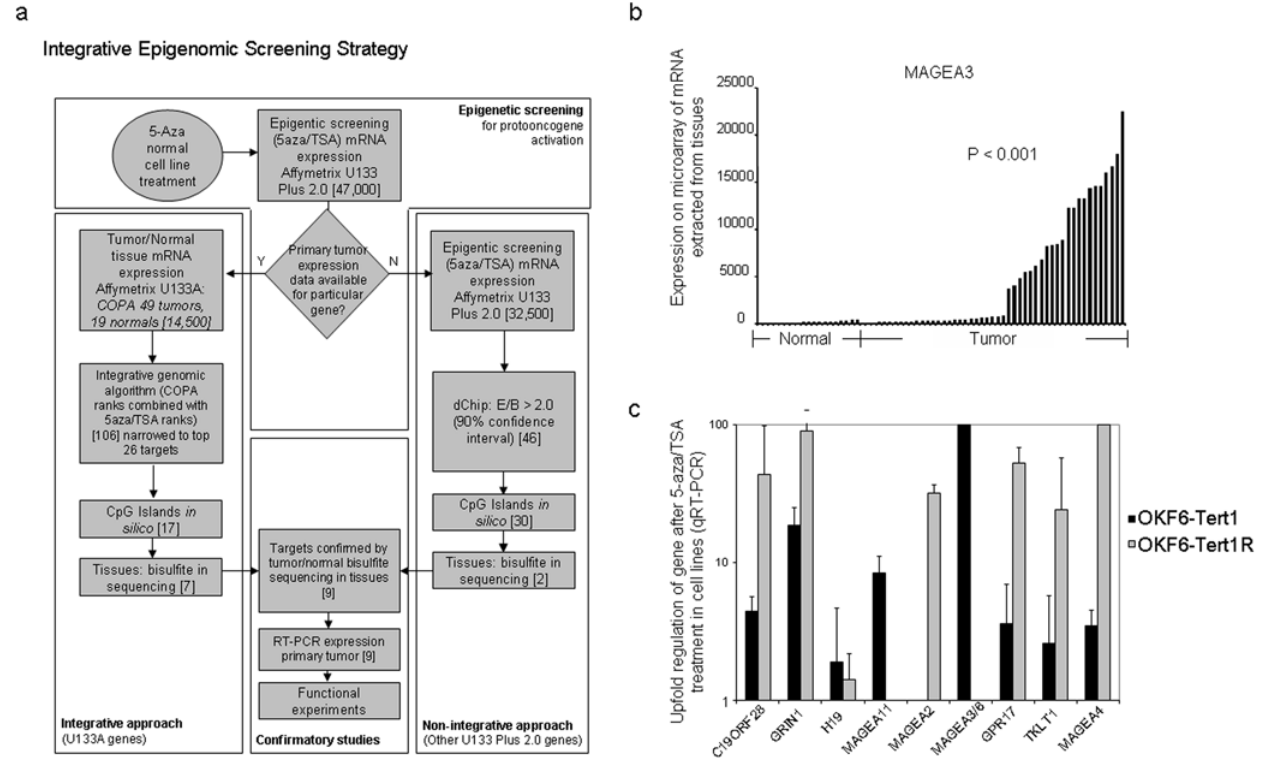
Figure 1. Integrative epigenetic screening strategy and strategy for validation of targets. ( a ) Initially, minimally-transformed cell lines were treated with 5-aza-deoxycytidine and TSA to unmask epigenetically silenced genes. In order to correlate epigenetic unmasking with meaningful upregulated cancer-specific genes, we performed a comparative epigenetic approach with Cancer Outlier Profiling Analysis (COPA) using 49 tumors and 19 normal tissues that had been characterized on the Affymetrix U133A mRNA expression microarray platform. Genes (by probeset) were ranked first by degree of upfold regulation with 5-aza/TSA treatment and second by COPA upregulation at the 90 th percentile. The product of these ranks was used to rank all targets and a significance threshold ( a =0.005) was chosen resulting in 106 genes of which the top 26 genes were evaluated. In order to not exclude genes outside the U133A platform, we also considered all other genes in the U133 Plus 2.0 platform on the sole basis of 5-aza/ TSA upfold regulation. Genes were subsequently screened by presence of CpG islands using MethPrimer and all genes were validated by bisulfite sequencing of tumor and normal tissues, and QRT-PCR of cell lines and primary tumors. Of the integrative targets 7/26 passed our validation, while 2/ 46 of the non-integrative targets passed. Functional experiments were then conducted on these genes. ( b ) Representative COPA graph of MAGEA3 demonstrating the statistical approach to finding candidate overexpressed oncogenes. Difference in tumor (n=49) versus normal (n=19) expression was significant, p value , 0.001 measured by Mann-Whitney U test. ( c ) Promoter demethylation causes transcriptional upregulation. Upregulation after treatment with 5-aza/TSA is shown in cell lines as measured by QRT-PCR. The ratio of 5-aza/TSA treated expression to baseline is shown for C19ORF28 , H19 , TKLT1 , GPR17 , GRIN1 , MAGEA2 , MAGEA3/6 , MAGEA4 , MAGEA11 . Each gene demonstrated significant upregulation by 5-aza/TSA treatment in at least one cell-line. Error bars show SE.